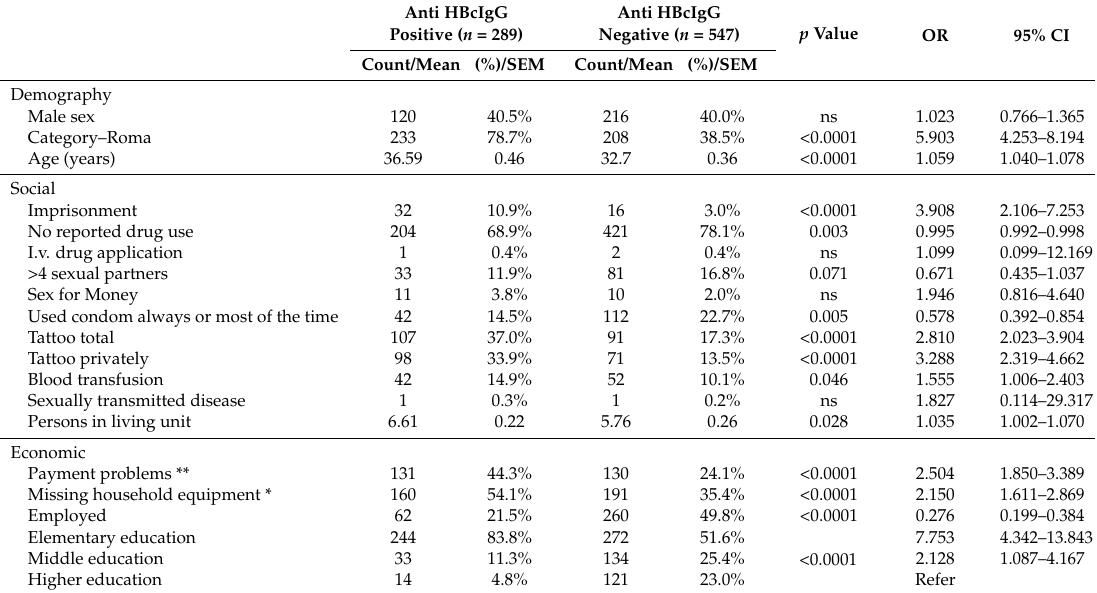
Table 4. Risk factors for antiHBcIgG positivity. SEM—Standard error of mean, CI—Confidence interval, OR—Odds ratio,